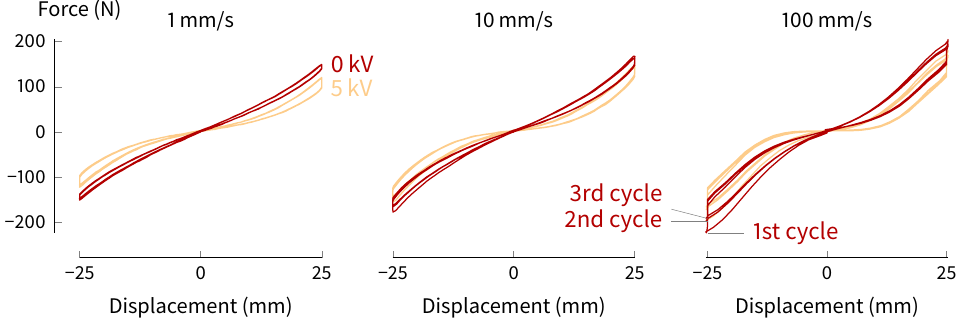
Figure 9. The viscoelasticity of the DET modules caused them to exert more force and have more hysteresis when the variable-stiffness mechanism was displaced more rapidly. The force-displacement trajectories settled towards a steady-state response producing peak forces of less magnitude on each subsequent cycle. The loops progress in a clockwise direction, so the hysteresis is dissipative.